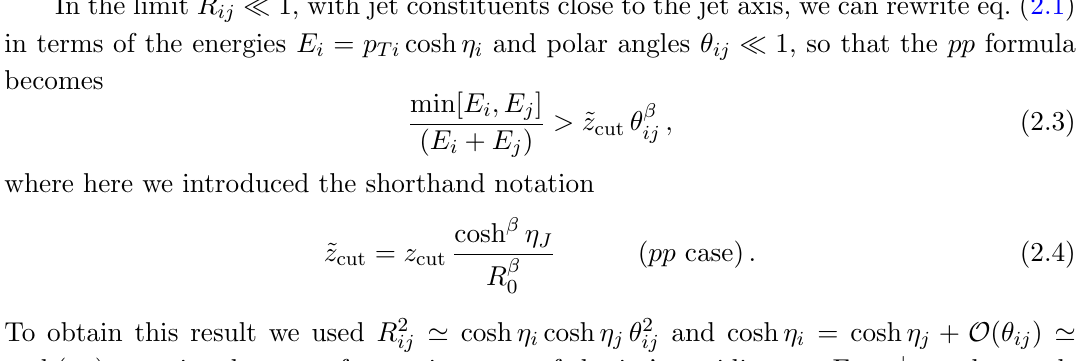
(cid:29) p + " constraint for the SDOE cs (cid:3)